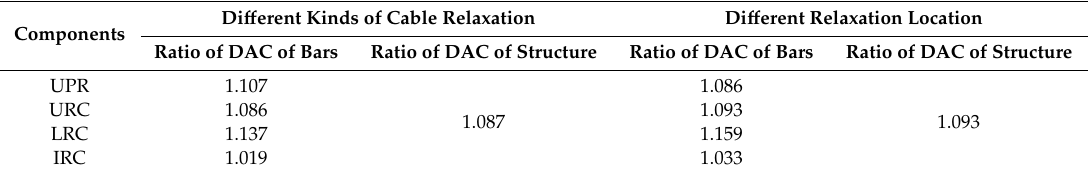
Table 5. Ratio of